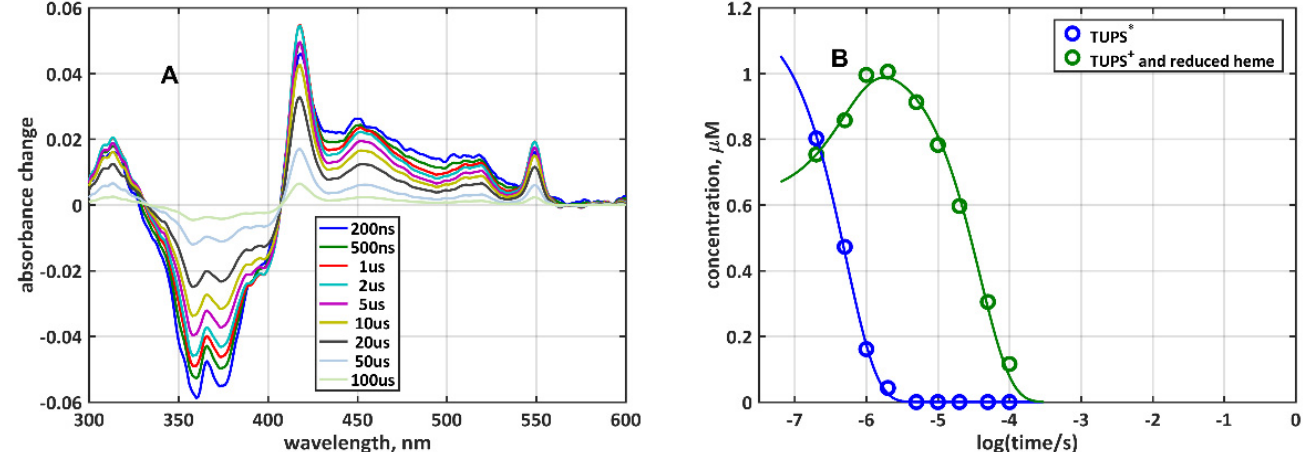
Figure 3. Kinetics of electron transfer between the dye and the heme in G77C-TUPS: ( A) Time-resolved difference spectra; ( B) time-dependent concentrations of the {TUPS T* + heme ox } and the {TUPS + + heme red } species (symbols), obtained by the least-squares fit of the spectra in ( A ) by the pure component spectra in Figure 2E, and fit to Scheme 1 (lines). The rate coefficients obtained from the fit are: k quench = 1.24 × 10 6 , k forward = 6.79 × 10 5 , and k reverse = 2.59 × 10 4 s − 1 .